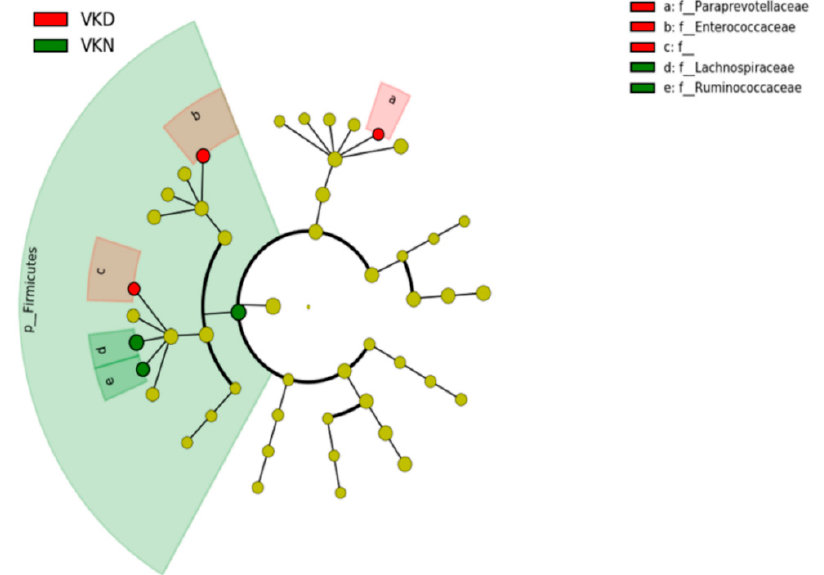
Figure 6. Gut microbiota at the family level in the vitamin K-satisfactory state. Abundant gut microbiota at the family level were highlighted on the phylogenetic tree using the GraPhlAn software. Colors distinguish between vitamin K-normal group (green) and vitamin K-deficient group (red), and the intensity reflects the linear discriminant analysis (LDA) score. The size of the nodes correlates with their relative and logarithmically scaled abundances. VKN, vitamin K-normal group; VKD, vitamin K-deficient group; c: f__, c: order__ Clostridiales ; family__; f_, family.